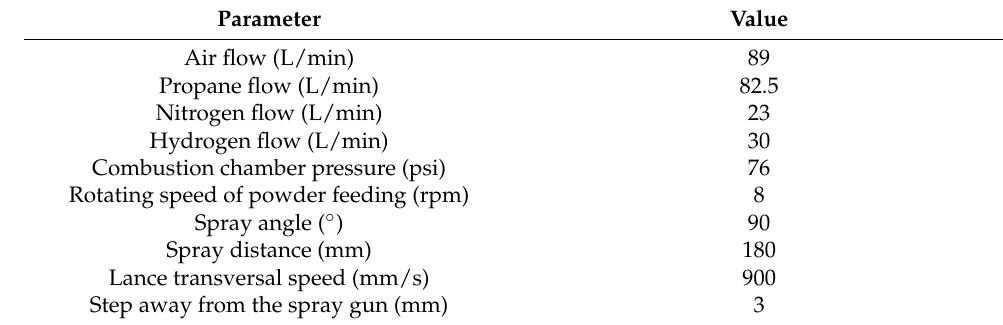
Table 2. Spraying process parameters of FeB-30 wt.% Al 0.25 FeNiCoCr